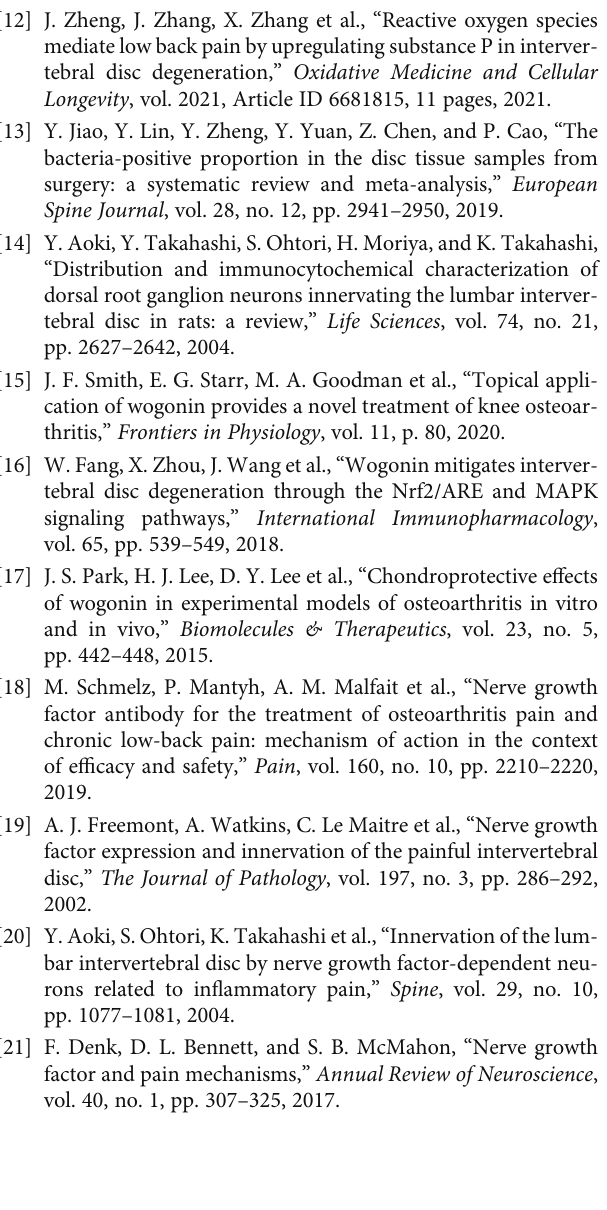
Supplementary Table 1: the molecular complex detection (MCODE) algorithm analysis for functional description of the corresponding components.